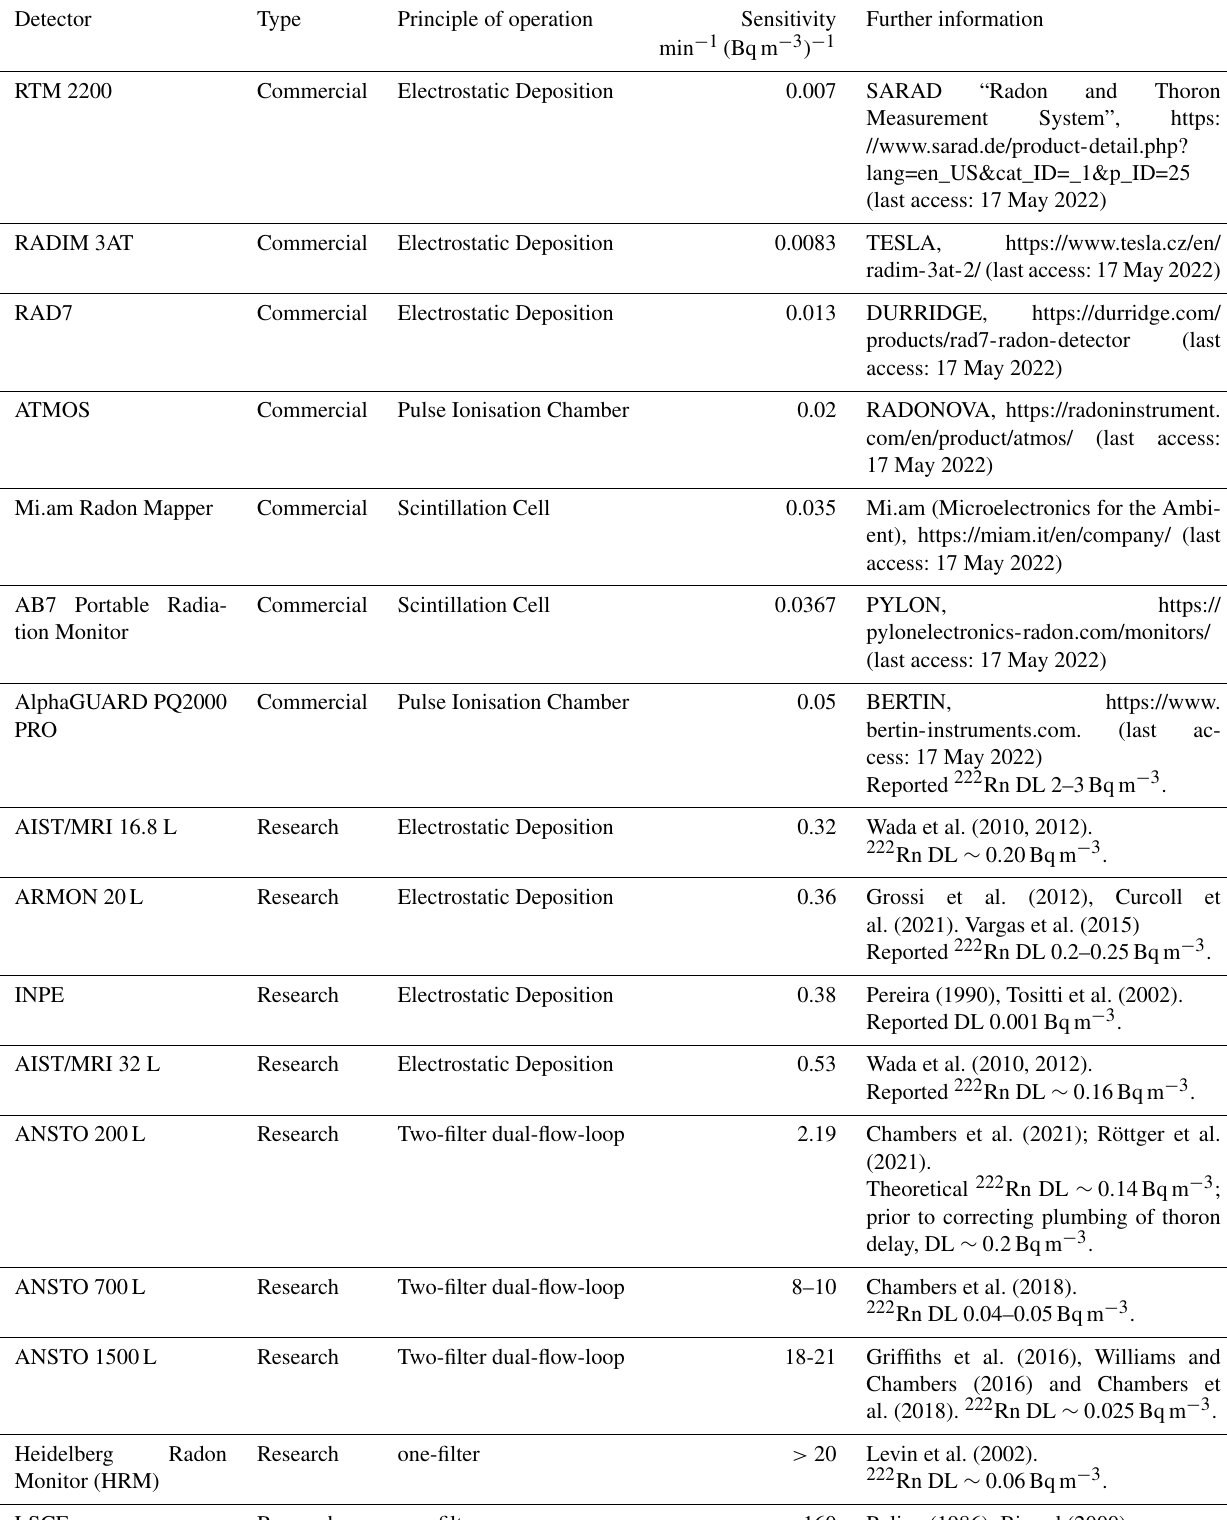
Table 1. A selection of contemporary radon monitors in order of their reported sensitivity to 222 Rn. Detector